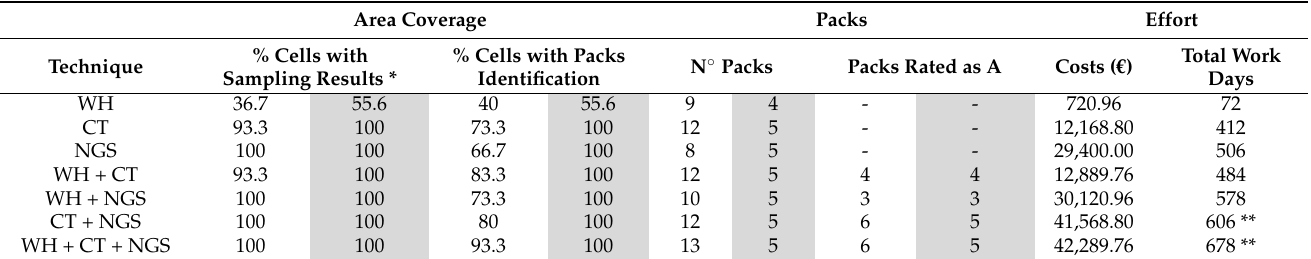
Table 2. Yield (area coverage and packs) and effort (costs and workdays) of each technique: wolf howling, camera trapping, non-invasive genetic sampling and all integrated